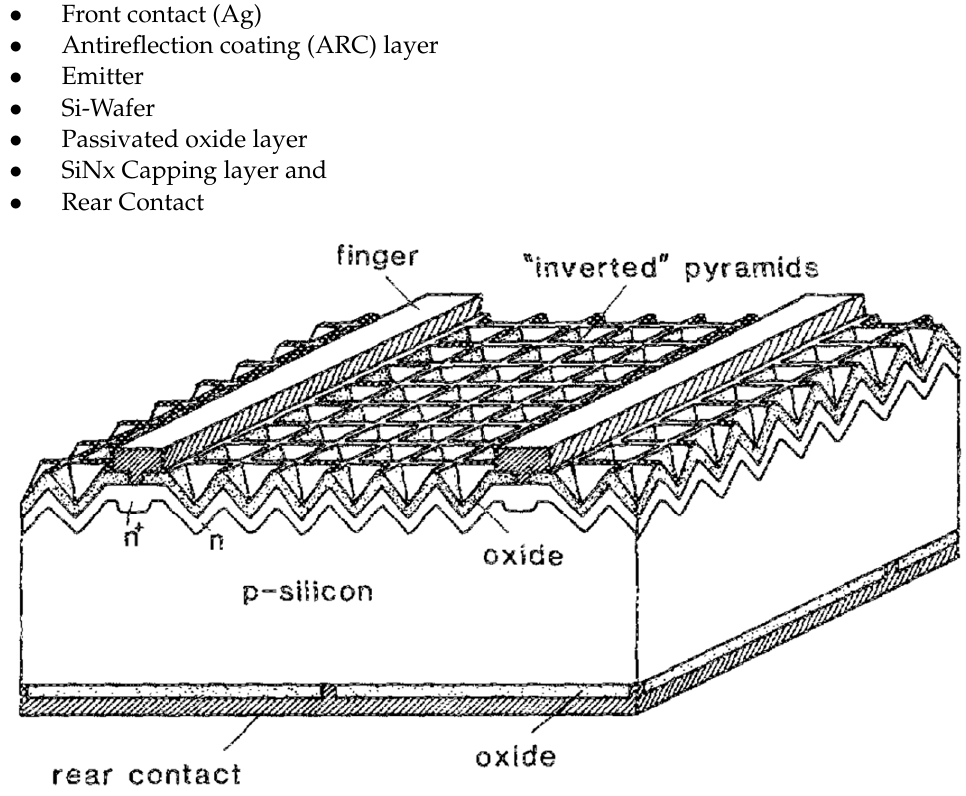
Figure 2. Structure of the first PERC cell. Reprinted/adapted with permission from Ref. [19]. 1989, AIP publishing.